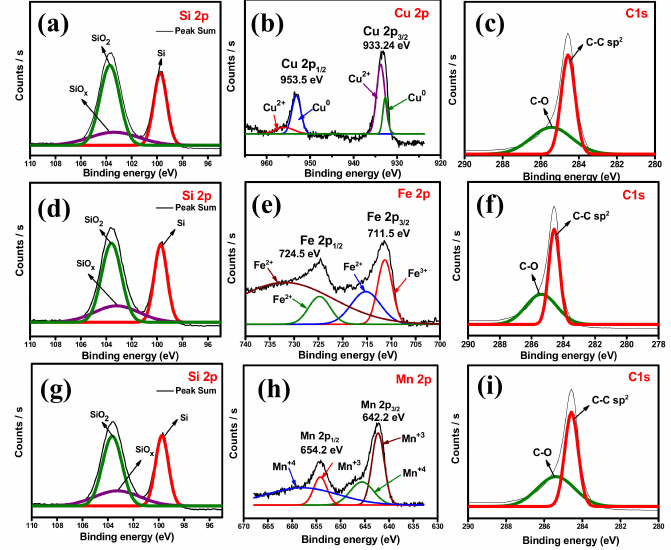
Figure 7. High-resolution XPS-spectra. ( a ) Si 2p, ( b ) Cu 2p, ( c ) C 1s of SiCuG. ( d ) Si 2p, ( e ) Fe 2p, ( f ) C 1s of SiFeG. ( g ) Si 2p, ( h ) Mn 2p, ( i ) C 1s of